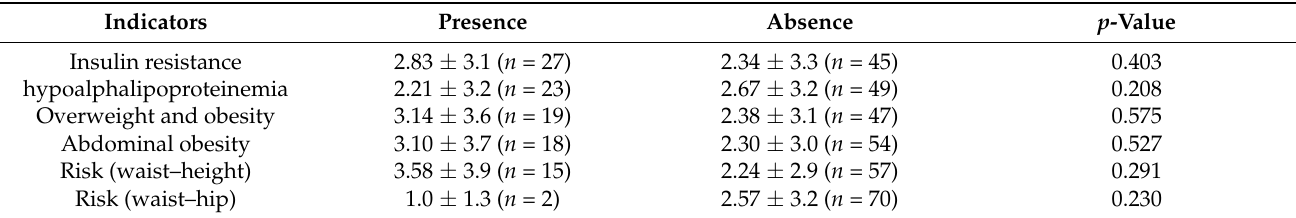
Table A8. IL-6 concentration in presence of metabolic